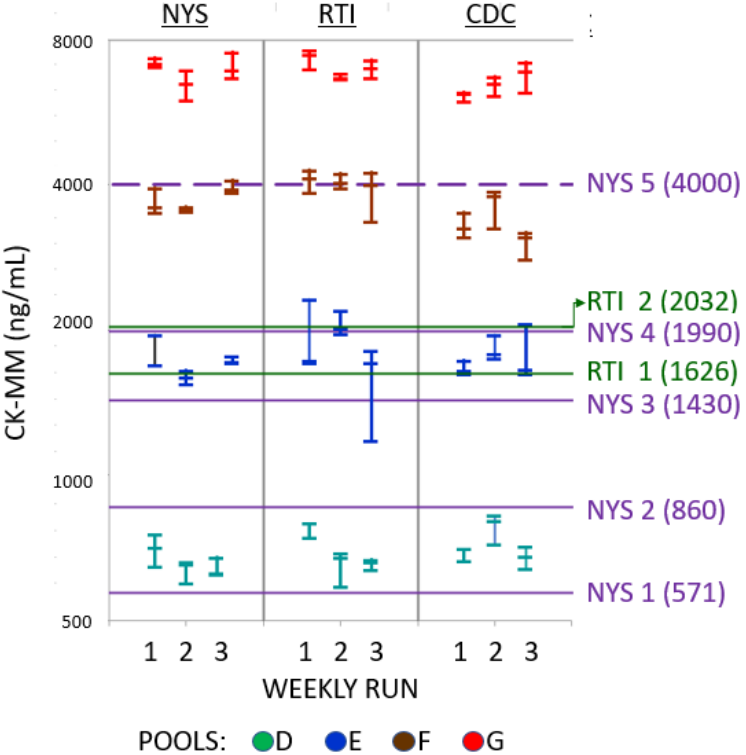
Figure 2. Distribution of CK-MM results from all laboratories for DBS made from Pools D–G. The three measured results from each laboratory for triplicate samples over the three weekly runs (X-axis) are displayed in the same column. Measured CK-MM levels are shown in logarithmic scale on the Y-axis. Cutoff values for screen positive results based on post-natal age are shown as horizontal lines labeled on the right, with CK-MM levels (in ng/mL) in parentheses. NYS actionable age-related cutoffs: NYS-1 > 168 h; NYS-2 72–167 h; NYS-3 48–71 h; NYS-4 < 47 h. All newborns with CK-MM results ≥ 4000 ng/mL (NYS-5) were immediately referred. Any newborn whose specimen